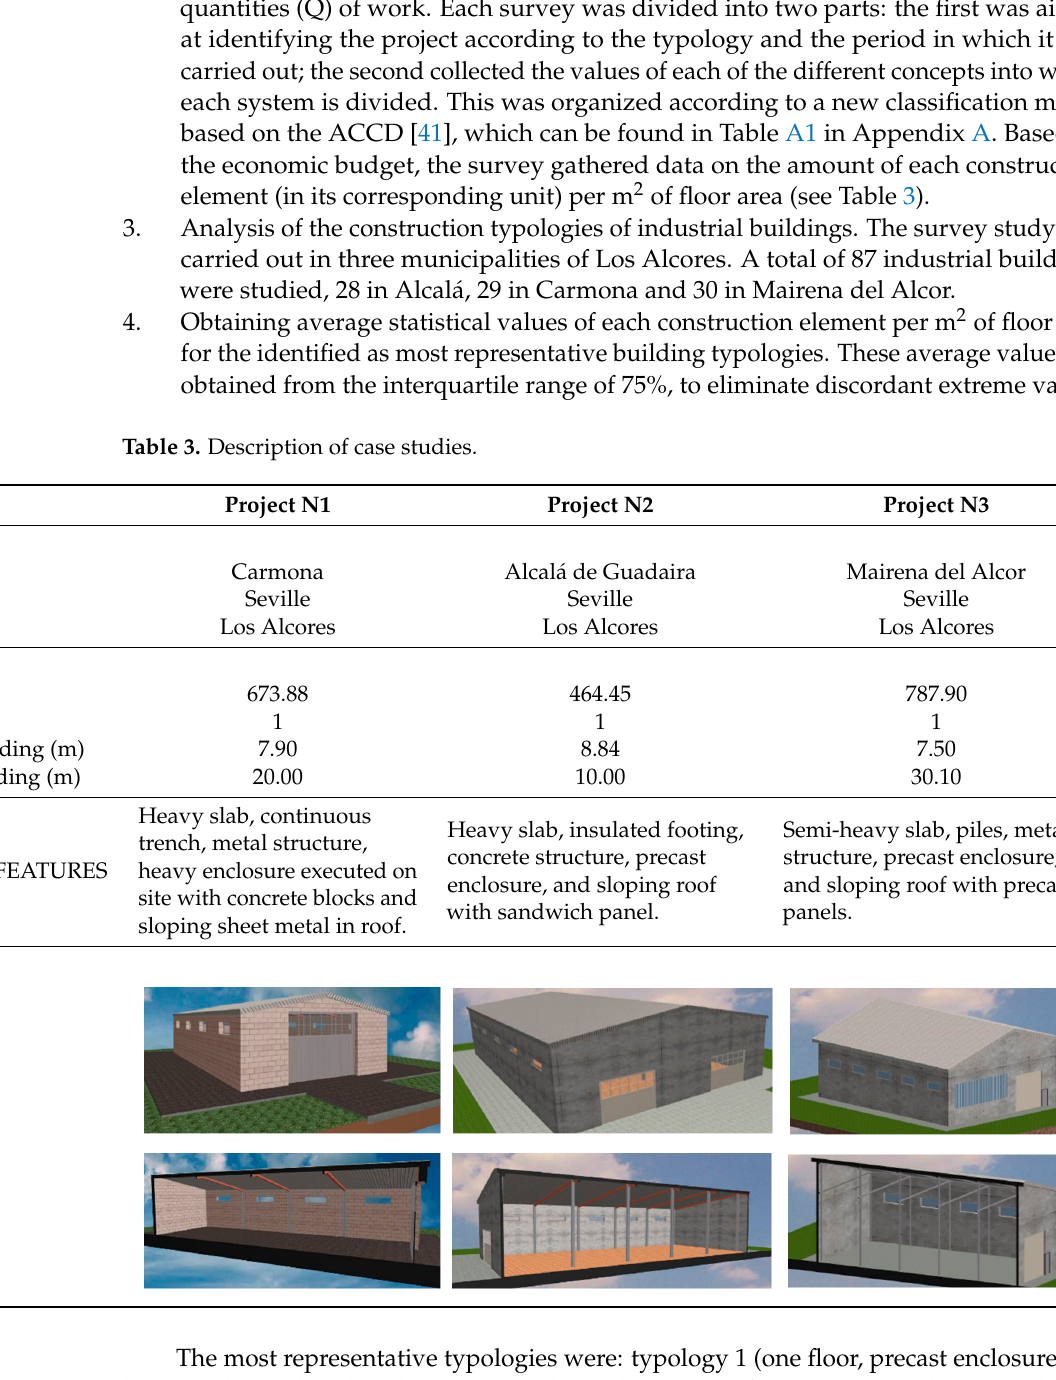
Table 4. Bills of quantities of the three case studies according to the systematic classification defined in Table A1.